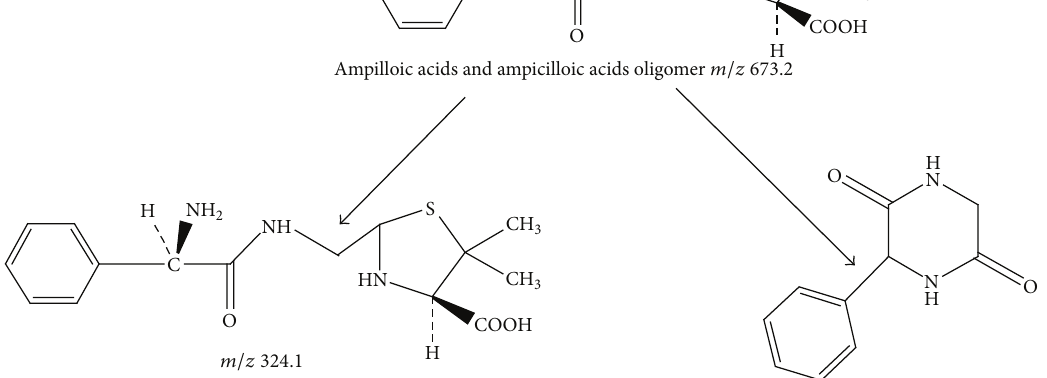
Figure 11: Proposed fragmentation pathway for the fragmentation ion of ampilloic acids and ampicilloic acids